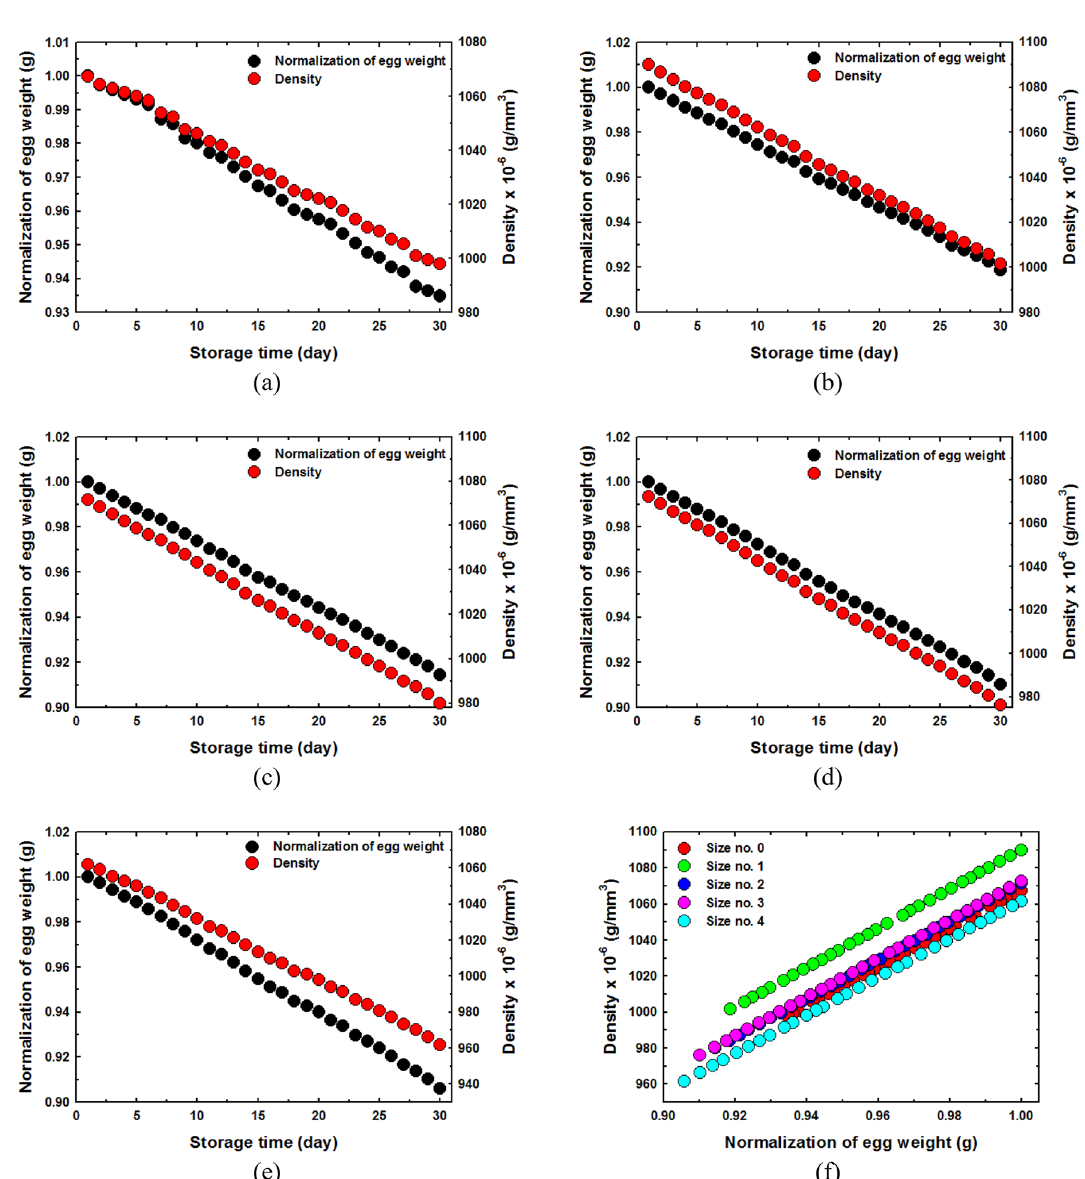
Figure 8. Weight and density as function of storage time ( a ) size classification number 0, ( b ) size classification number 1, ( c ) size classification number 2 ( d ) size classification number 3, ( e ) size classification number 4 and ( f ) relationship between normalized weight and density of all eggs